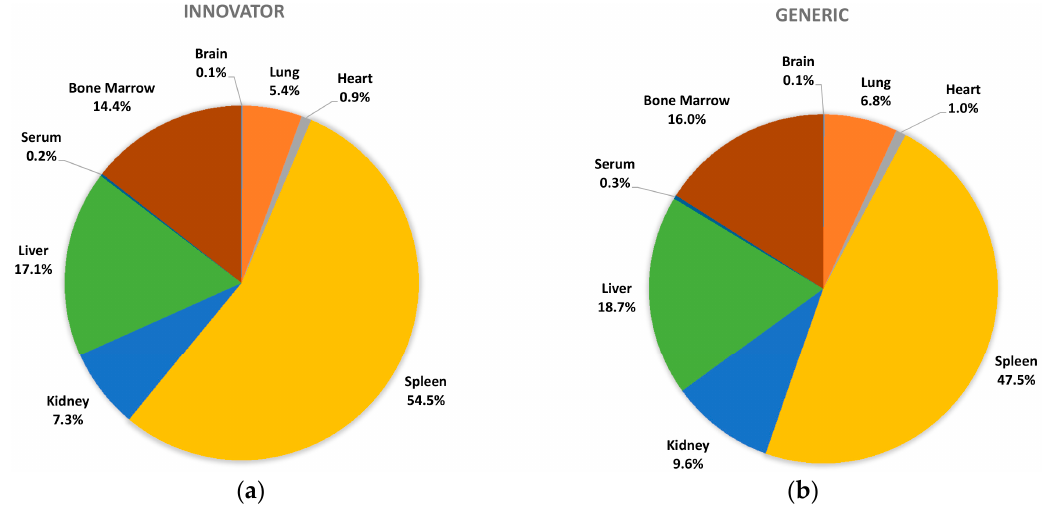
Figure 10. AUC calculated using Phoenix WinNonlin; for tissues: AUC calculated from 0 to 60,480 min—where conc. at t 0 = 0 µg/g; for serum after subtraction control values from both ( a ) innovator and ( b ) generic drug values.